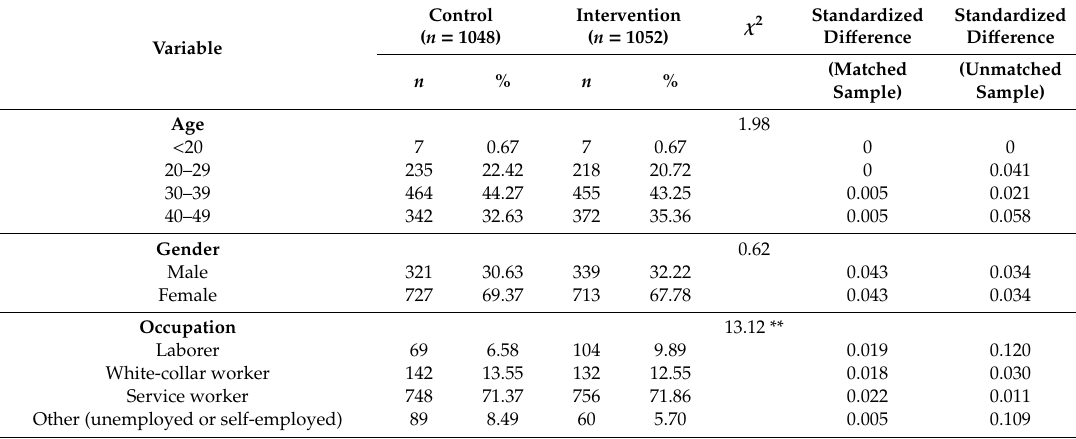
Table A3. Comparison of demographic characteristics among participants between intervention and control groups in Beijing ( n =